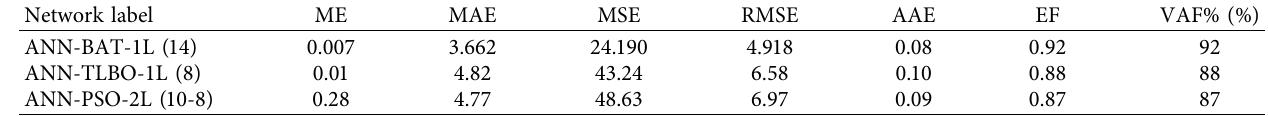
Table 8: Error metrics of top ANNs trained by using BAT, PSO, and TLBO methods on training data. Network label